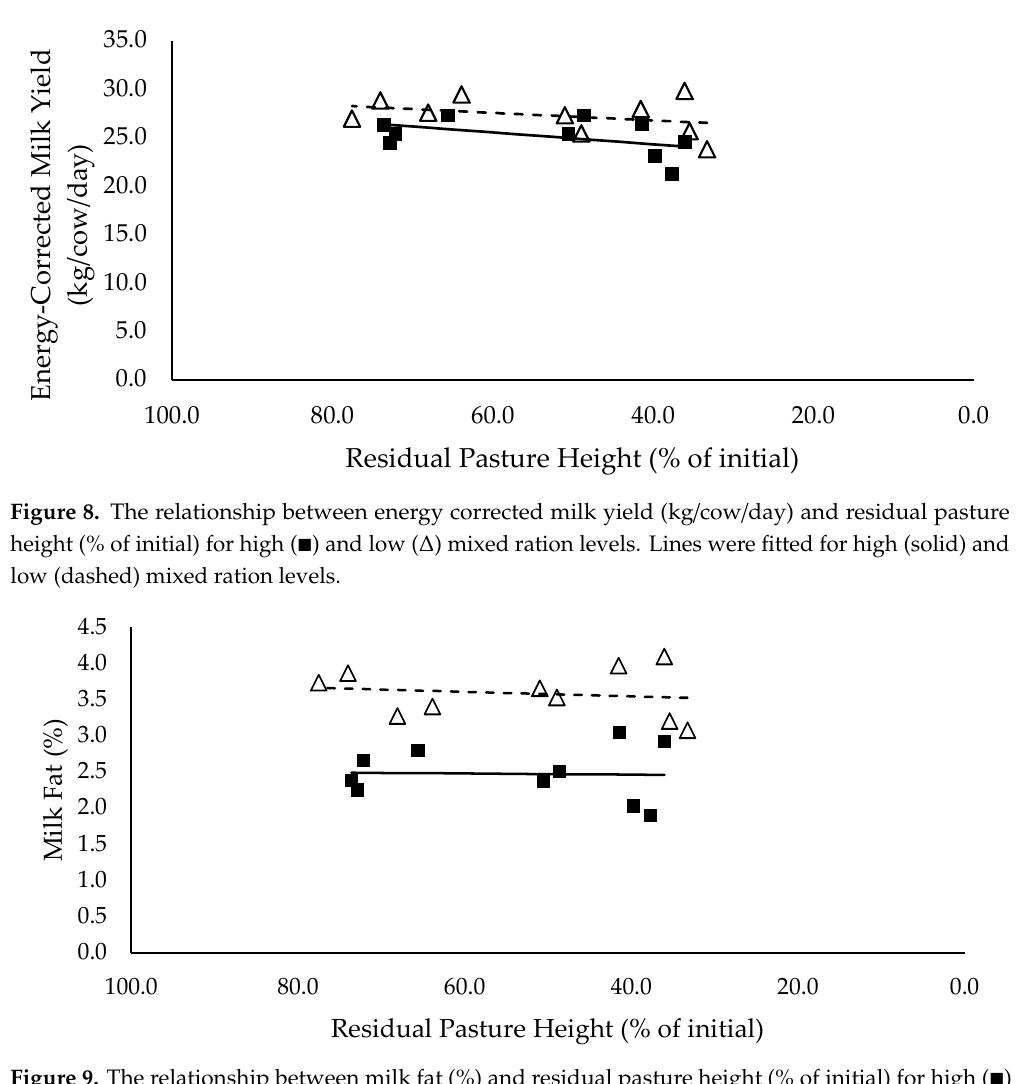
Figure 7. The relationship between milk yield (L / cow / day) and residual pasture height (% of initial) for high ( ■ ) and low (Δ) mixed ration levels. Lines were fitted for high (solid) and low (dashed) mixed ration levels.